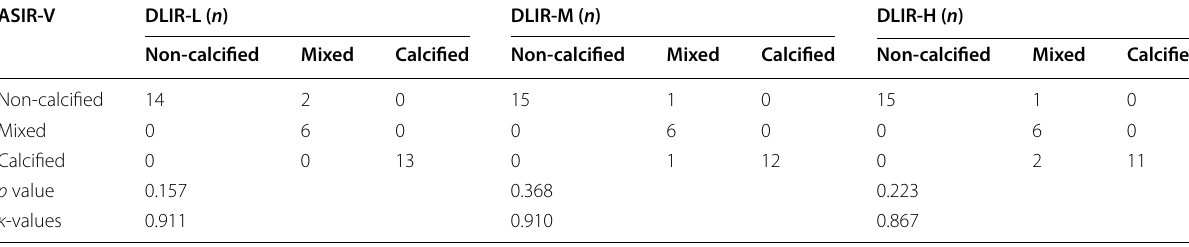
ASIR, adaptive statistical iterative reconstruction-Veo; DLIR, deep learning image reconstruction (low strength, DLIR-L; medium strength, DLIR-M; high strength, DLIR-H)